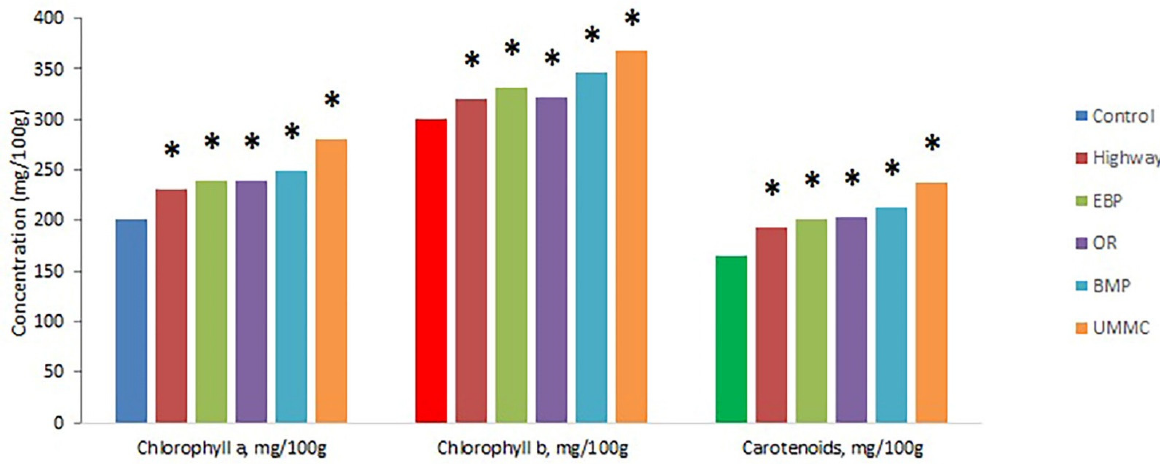
Figure 5. Concentration of photosynthetic pigments in coltsfoot from studied areas. *—statistically significant difference between control and test group ( p ≤ 0.05).